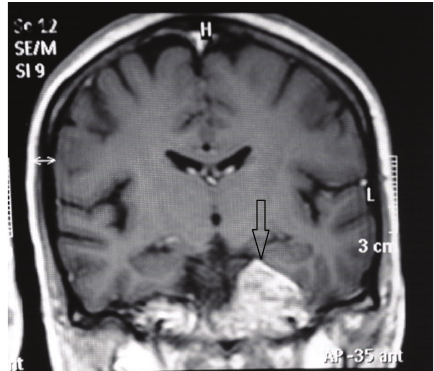
Figure 3: MRI precontrast showing altered signal intensity of the clivus, coronal section that appears hyperintense.